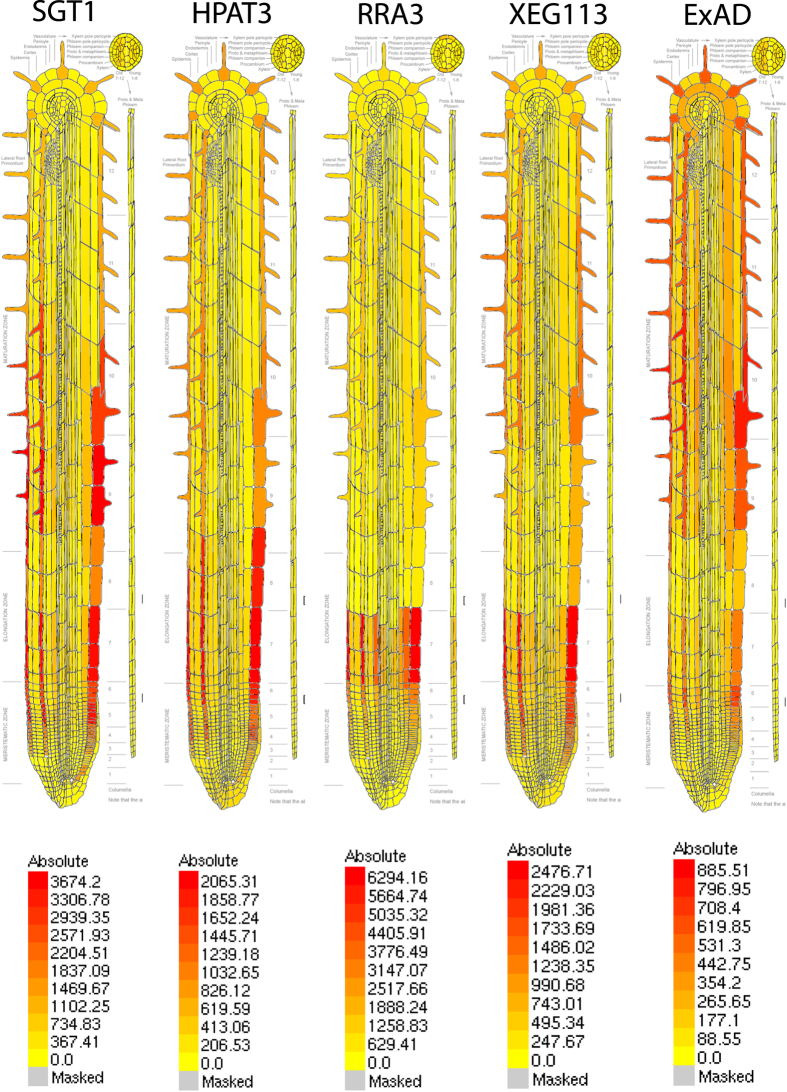
ExAD is highly expressed in root hair cells.Expression of ExAD in root epidermis and root hair cells is similar to the expression pattern of the previously characterized extensin Araf Ts HPAT322, RRA320, XEG11320) and the Ser-GalT18 (SGT). Expression patterns were obtained using eFP-Browser66 (http://www.bar.utoronto.ca/) and the dataset of Brady et al.51 as described in the Material and Methods section.